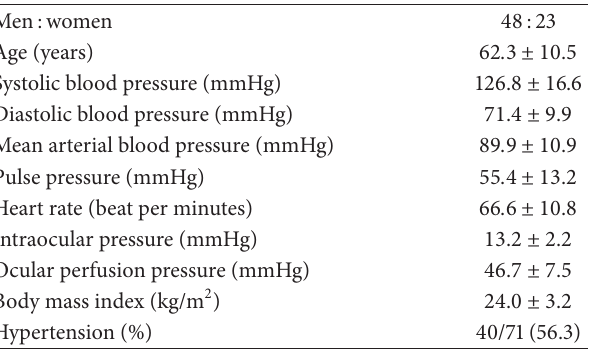
Table 3: The results of serum creatinine, estimated glomerular